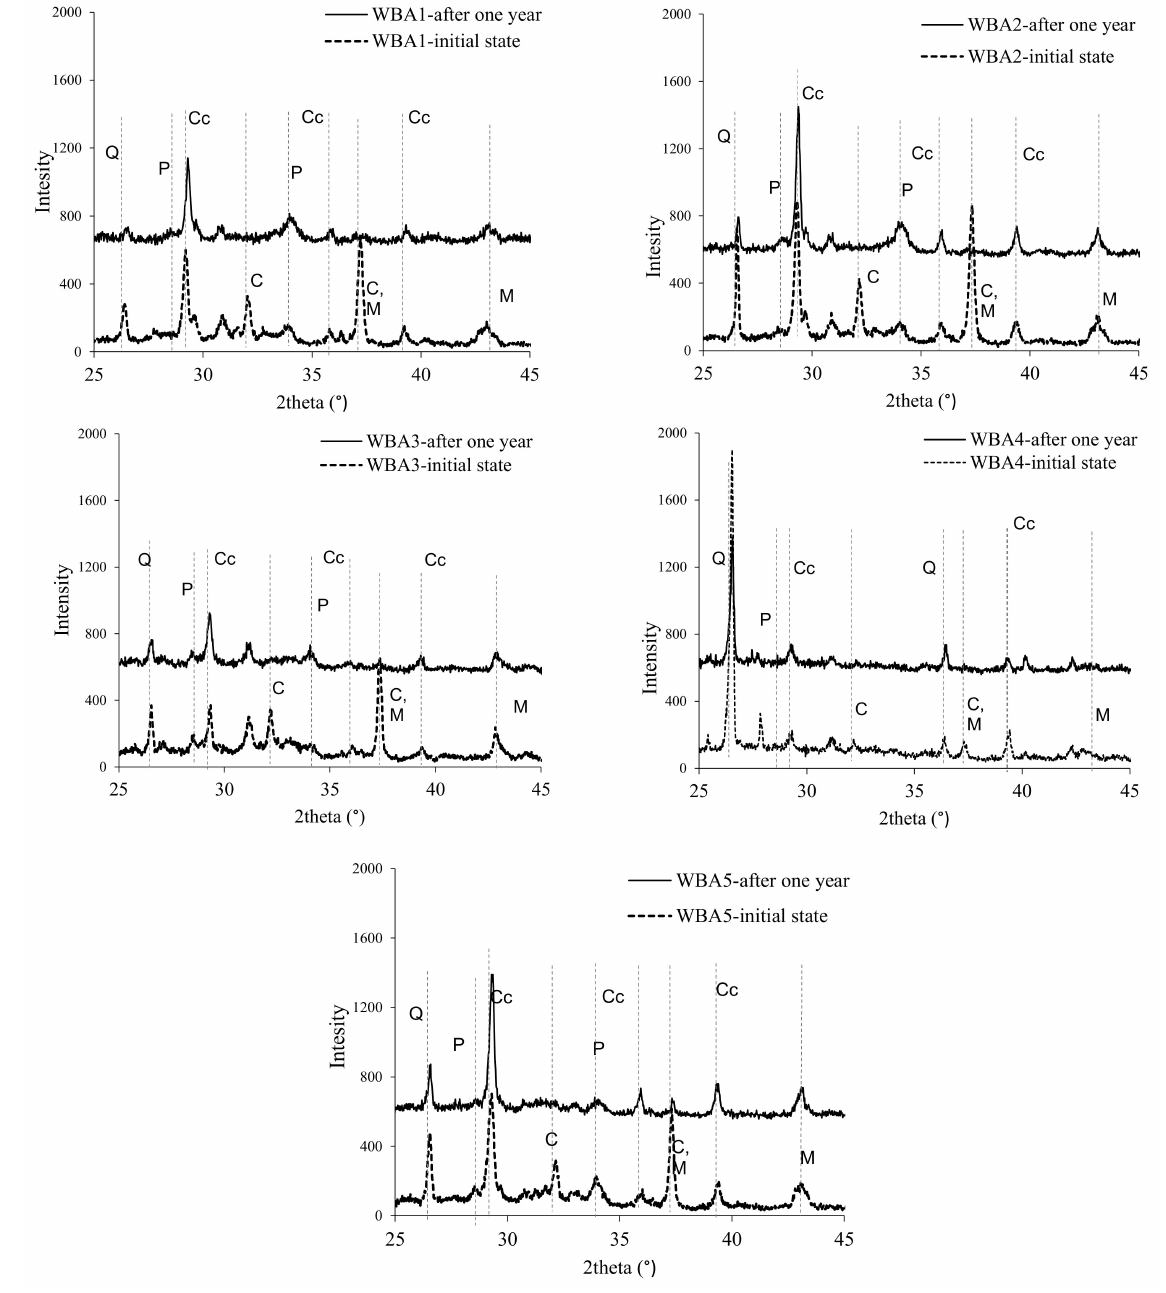
Figure 7. XRD diffractograms of WBA samples after collecting from power plants and after one year of storage in closed containers (the data are available in Supplementary